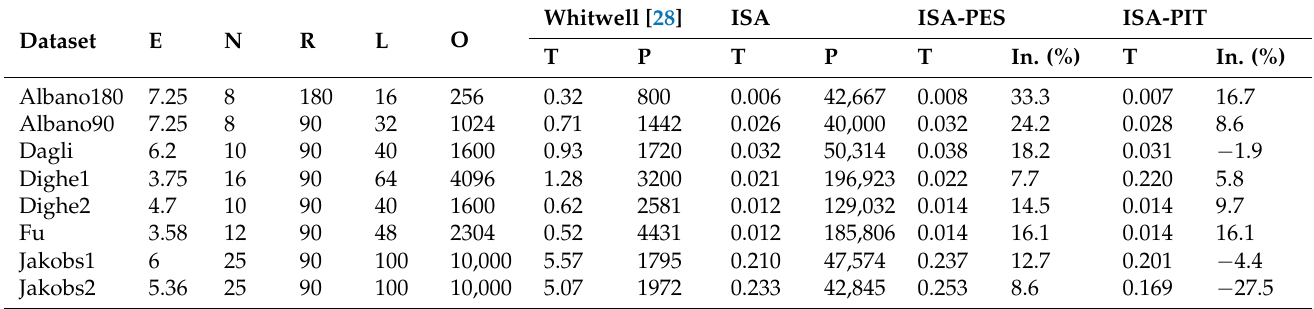
Table 1. No-fit polygon creation times for 19 datasets from the